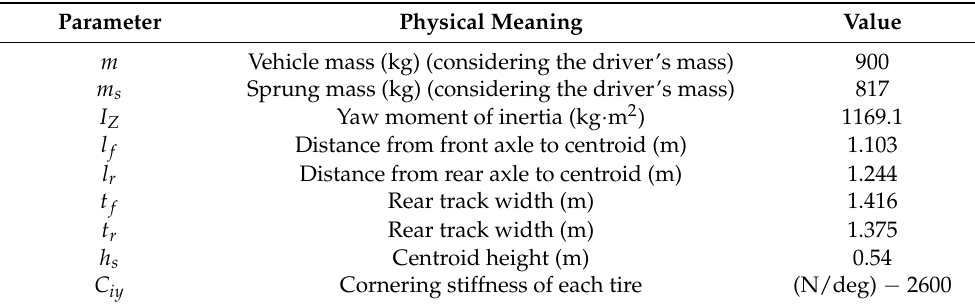
Table 1. CarSim vehicle model parameters based on full line controlled electric vehicles. Parameter Physical